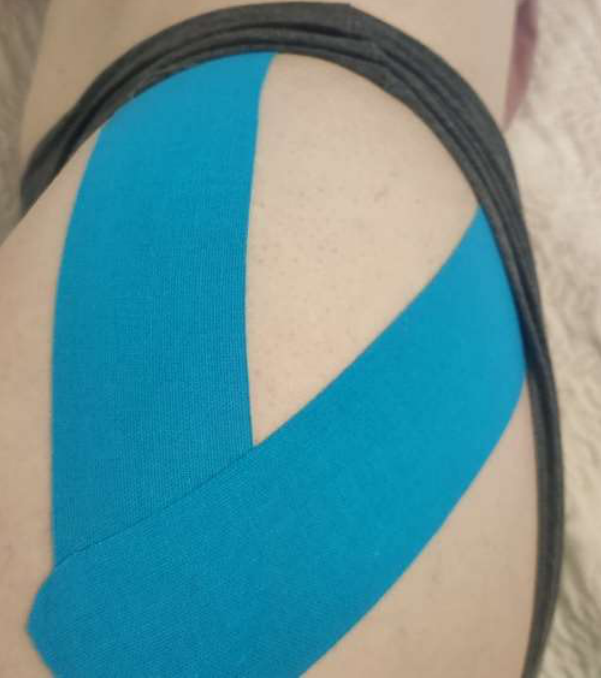
Figure 2. The method of kinesio tape application used.